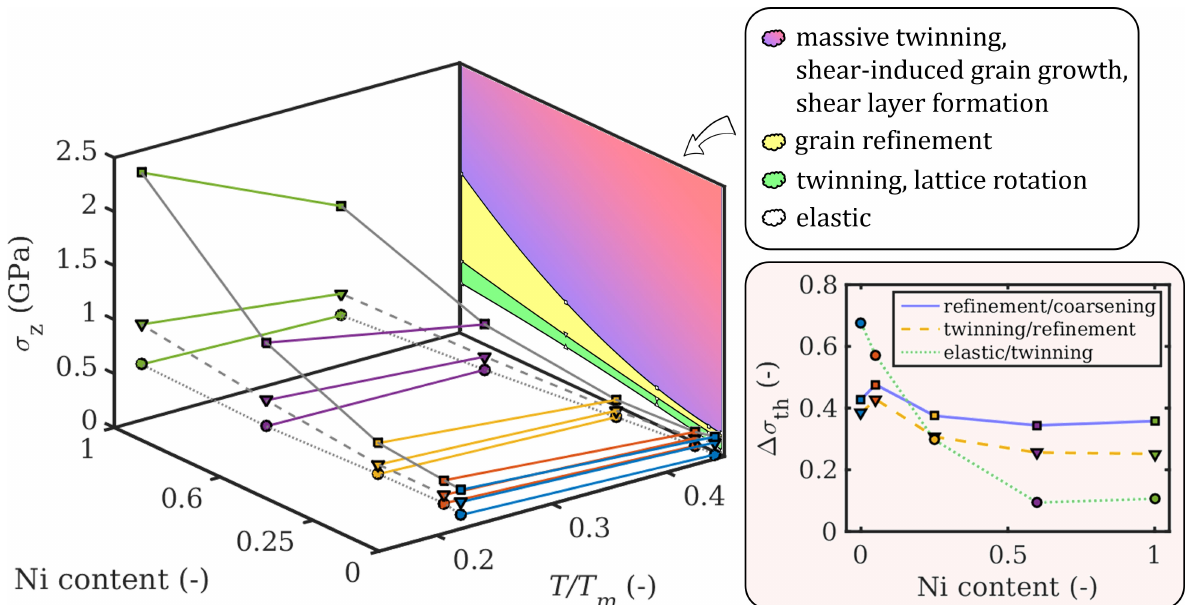
Figure 6. Threshold stresses σ z as a function of the homologous temperature and composition. Line colors denote compositions (same as above: Cu blue, Ni green). The gray lines connect the same type (=same symbol) of threshold stresses. Here, circles denote the upper boundary of the elastic regime, triangles of the twinning regime, and squares of the grain refinement regime. The map projected onto the back wall of the plot shows the distribution of the prevalent deformation mechanisms at 600 K, named in the legend. The panel in the bottom right shows the relative reduction of the threshold stresses between deformation mechanism regimes due to the temperature increase from 300 K to 600